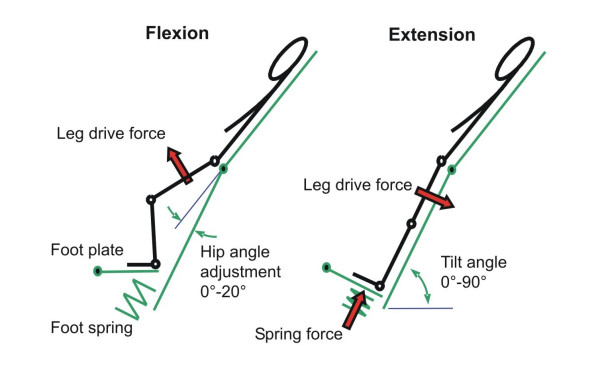
The tilt stepper: generation of leg movements